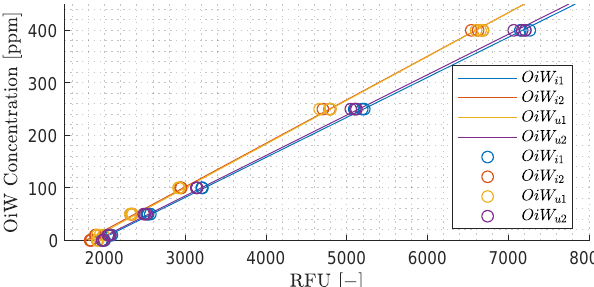
Figure 14. The four oil-in-water (OiW) monitors calibration curve obtained by least square regression and the known samples used to identify them.